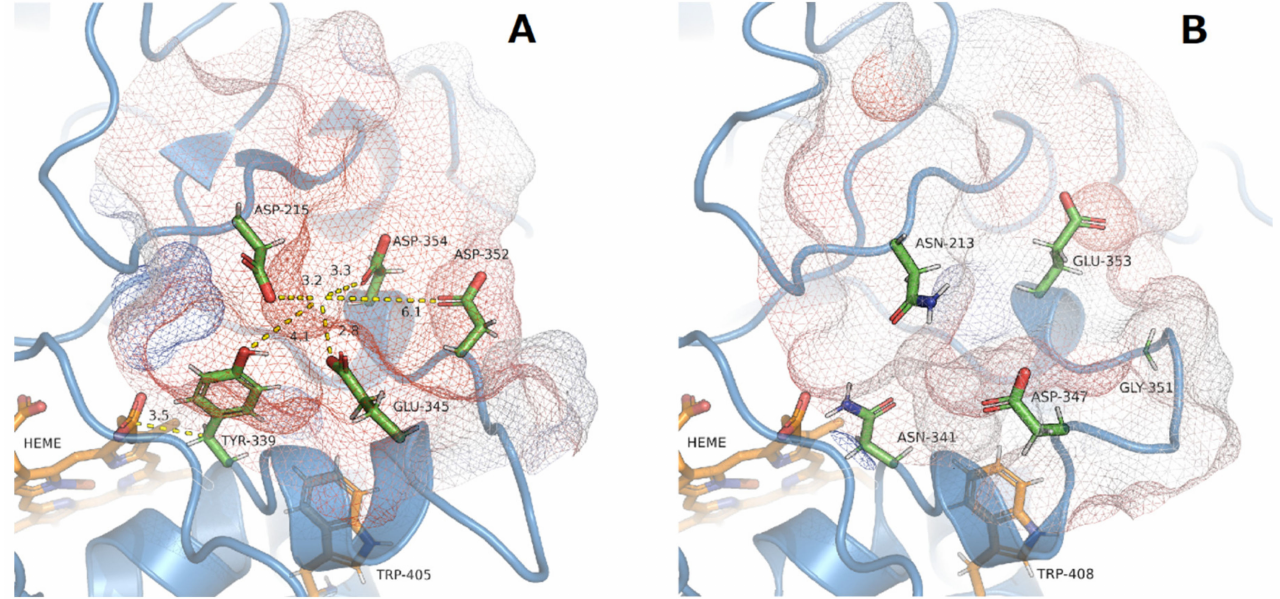
Figure 6. ( A ) Characterized Mn 2+ binding site and distribution of the coordinating acid amino acids and the electron transferring Tyr339 in r Pos DyP4 [56] (distances in Å are indicated yellow dotted lines) and ( B ) the corresponding analogous region in the hypothetical 3D structure of Xgr DyP g488 . The solvent excluded surface (SES) around the putative Mn 2+ binding site is given as a colored mesh from blue to red according to the electrostatic charge distribution (blue-positive, red-negative) and is used to approximate the hypothetic Mn 2+